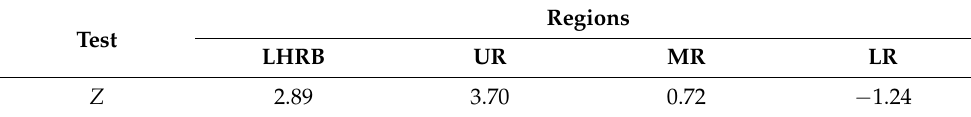
Table 2. Results of Mann–Kendall test of EQ in different regions from 2001 to